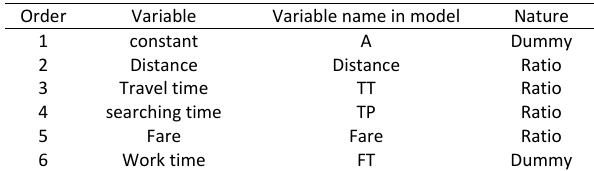
Fig. 2. Structure of nested logit model Table 2. Used variables in simultaneous model